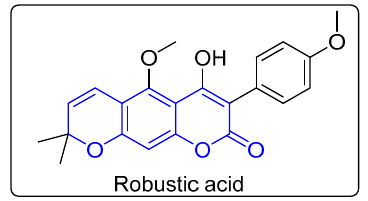
Figure 2. Structure of robustic acid (RA).